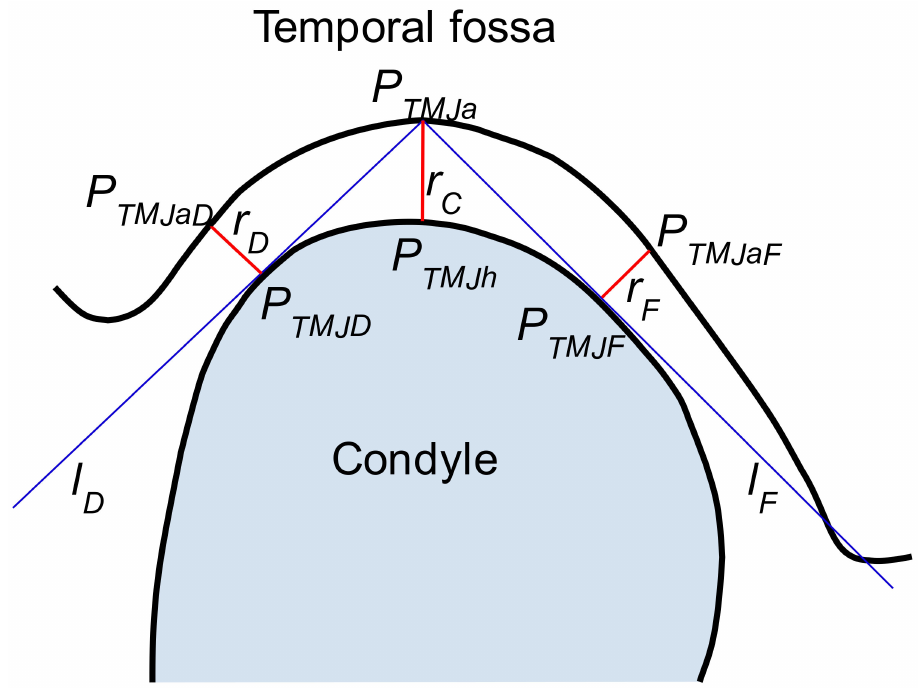
Figure 1. The schema of TMJ parameters